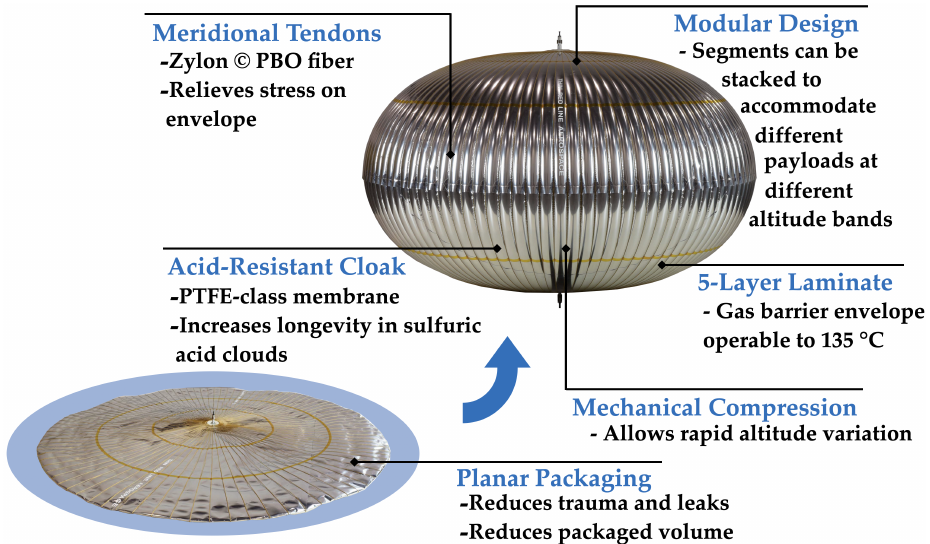
Figure 3. A Thin Red Line balloon